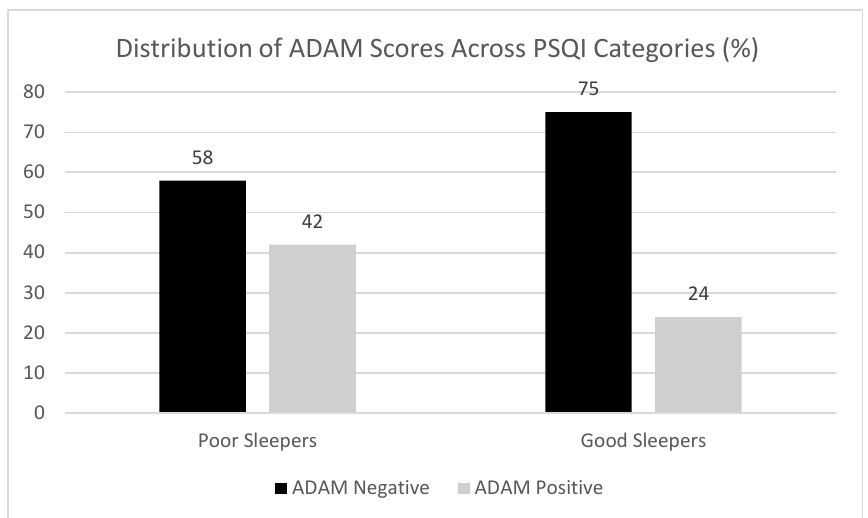
Figure 3. Distribution of ADAM Scores across PSQI Sleep Quality Categories. Participants with positive ADAM scores represented a larger percentage of the sample’s “poor sleeper” group (42%) than it did the “good sleeper” group (24%).